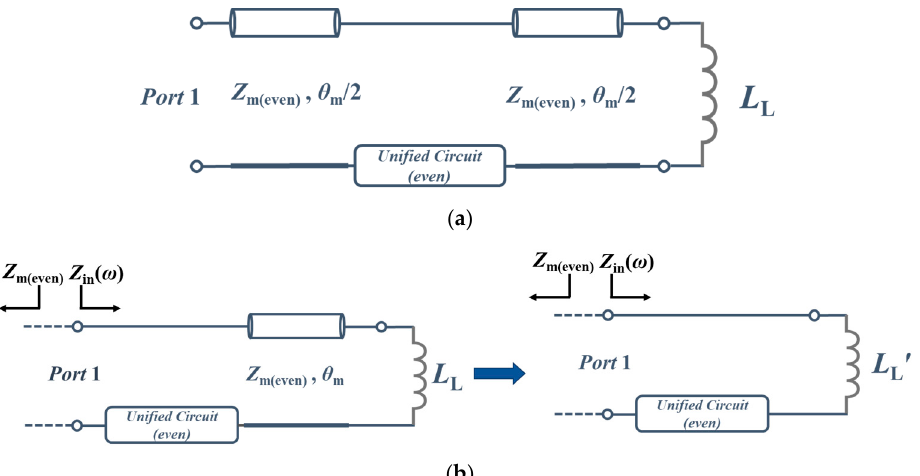
Figure 4. ( a ) The equivalent circuit of the whole structure; ( b ) Simplified Matching Stage with inductive load and use the inductor L L (cid:48) to alternate the inductor load L L with a transmission line.